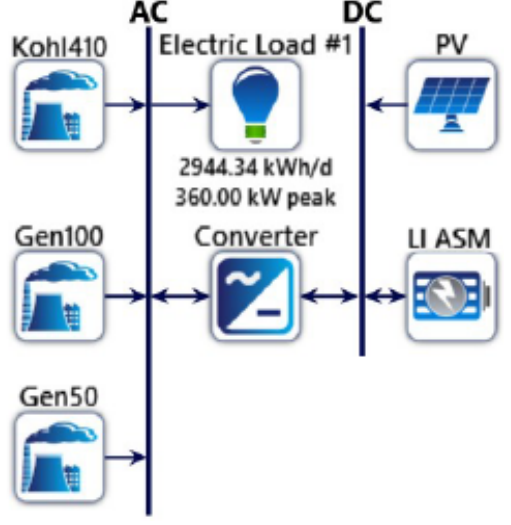
Figure 7. Scheme of the hybrid system with limited BESS solution.